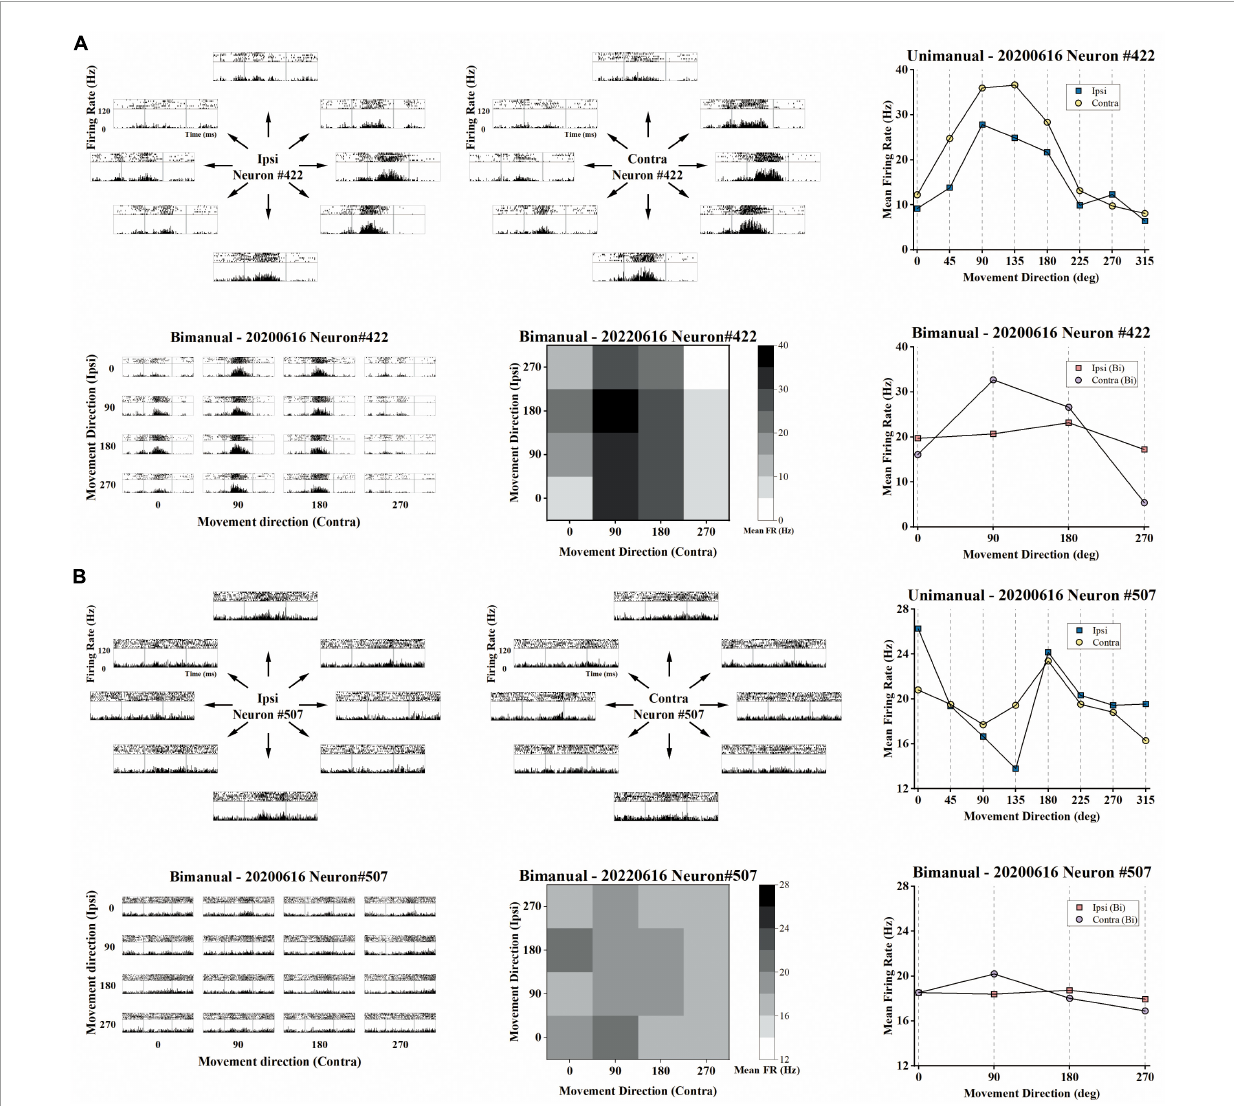
FIGURE3 Example of the representative neurons in the unimanual and bimanual tasks. (A) A typical neuron with a contralateral preference in both the unimanual and bimanual tasks. It also showed strongly correlated activity for each arm movement which can be quantified as the high correlation coefficient ( cc = 0.95) between their tuning curves. When switching to bimanual movements, it remained strongly correlated between arms ( cc = 0.89) even though substantive changes were observed in both MDs and PDs of ipsilateral-related activity. Top row the peri-event time histograms (PETHs) during ipsilateral (left column) and contralateral movements (middle column) performed on the same day. Each subplot of PETHs was aligned on the appearance of the go cue (left gray line in each subplot). The averaged firing rate in the unimanual task was depicted in the right column, for 8 movement directions of ipsilateral trials (blue squares) and of contralateral trials (yellow dots); Bottom row same as in the top row, PETHs for the same neuron in the bimanual task (left column). The average firing rate in the bimanual task was depicted in the heatmap in the middle column and the line chart in the right column. (B) The other type of neuron with ipsilateral preference during unimanual movements but it inverted preference during bimanual movements. The representation of ipsilateral and contralateral arm movements was decorrelated with decreased cc that changed from 0.57 to 0.22. These changes can be attributed to the PD shifts and great suppression in bilateral sides.